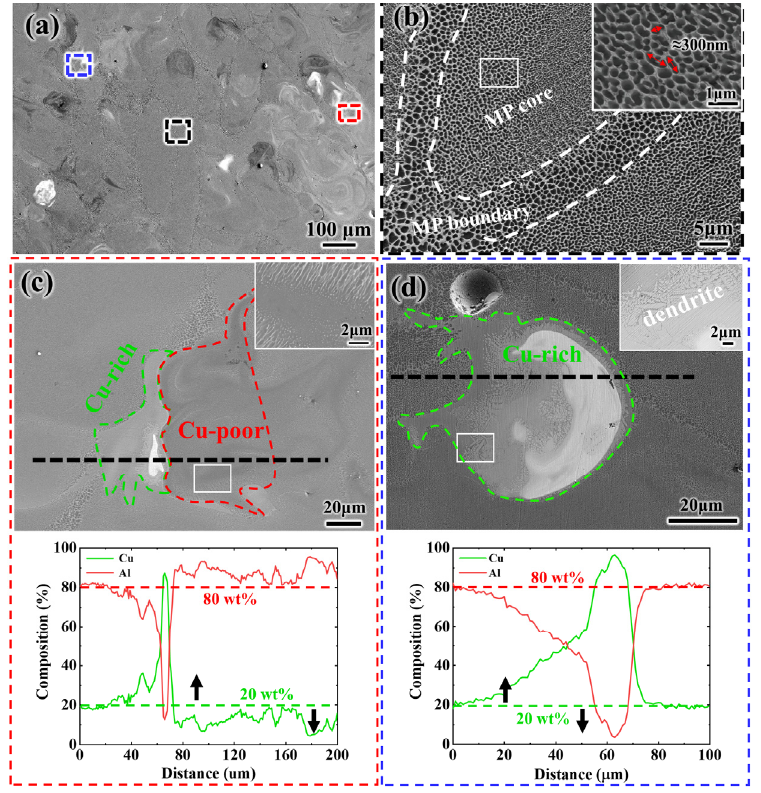
Figure 5. The microstructure of the cross-plane of an as-printed Al20Cu sample: ( a ) a representative SEM micrograph and an enlarged detail of ( b ) fully alloyed zone, ( c ) Cu-poor zone, and ( d ) Cu-rich zone. The EDS line analysis performed across the Cu-poor zone and Cu-rich zone is placed at the bottom of ( c , d ).